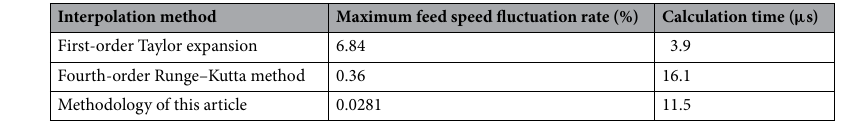
Table 2. Calculation comparison results of each interpolation algorithm.